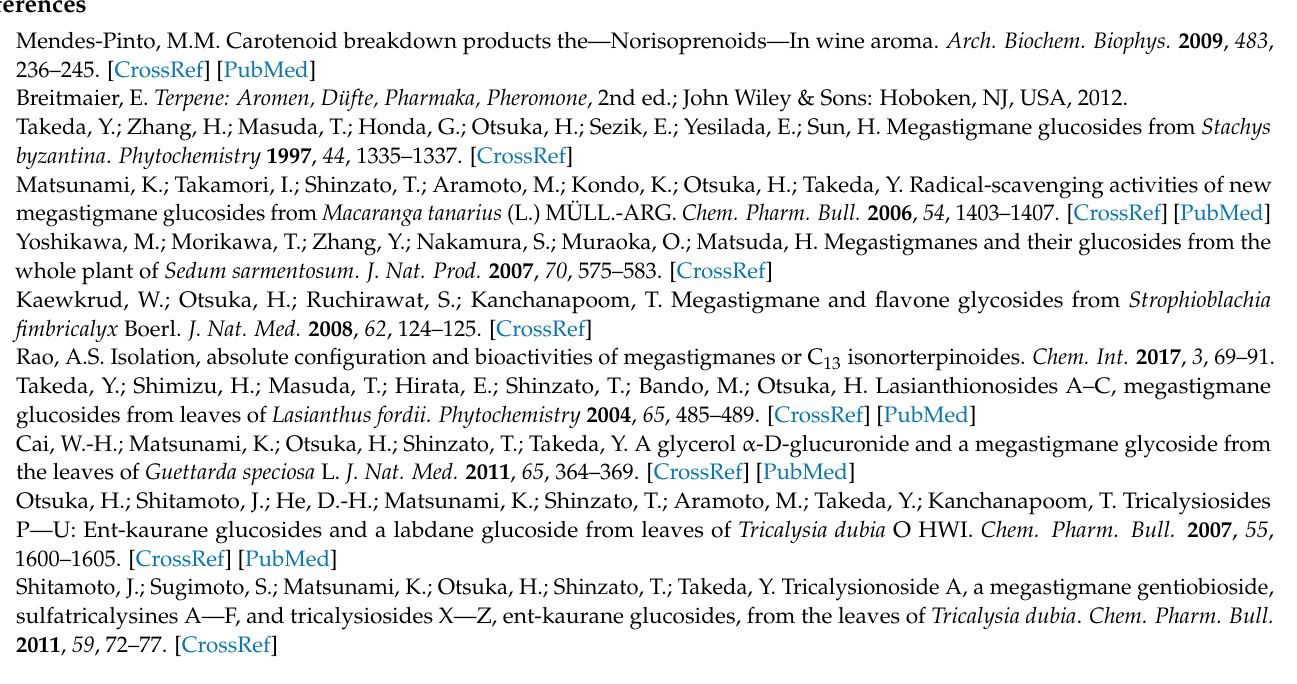
on EA3000 combined to the HT 1500 pyrolysis-system: TCD-trace of an analysis-run on sample A. Figure S17: O-Analysis on EA3000 combined to the HT 1500 pyrolysis-system: TCD-trace of an analysis-run on sample C. Figure S18: Comparison of two samples with a 10 µ M mixed anion standard containing bromide, chloride and sulfate; Figure S19: Calibration for chloride and sulfate; Table S1: DP4+ analysis results of 6 R *9 S *- 1a and 6 S *9 S *- 1b ; Table S2: Correlations between calculated (DP4+) and experimental 1 H and 13 C NMR chemical shifts of 6 R *9 S *- 1a and 6 S *9 S *- 1b ; Table S3: Table S4: 1 H and 13 C NMR spectroscopic data for blumenol C glucoside in CD 3 OD measured on a 600 MHz NMR; Table S5: 1 H and 13 C NMR of vomifoliol spectroscopic data in CD 3 OD measured on a 600 MHz NMR; Table S6: Detailed microchemical elemental analysis data for sample A–E.(Citation of